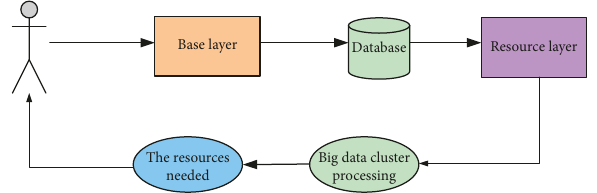
Figure 5: Flow chart of obtaining learning